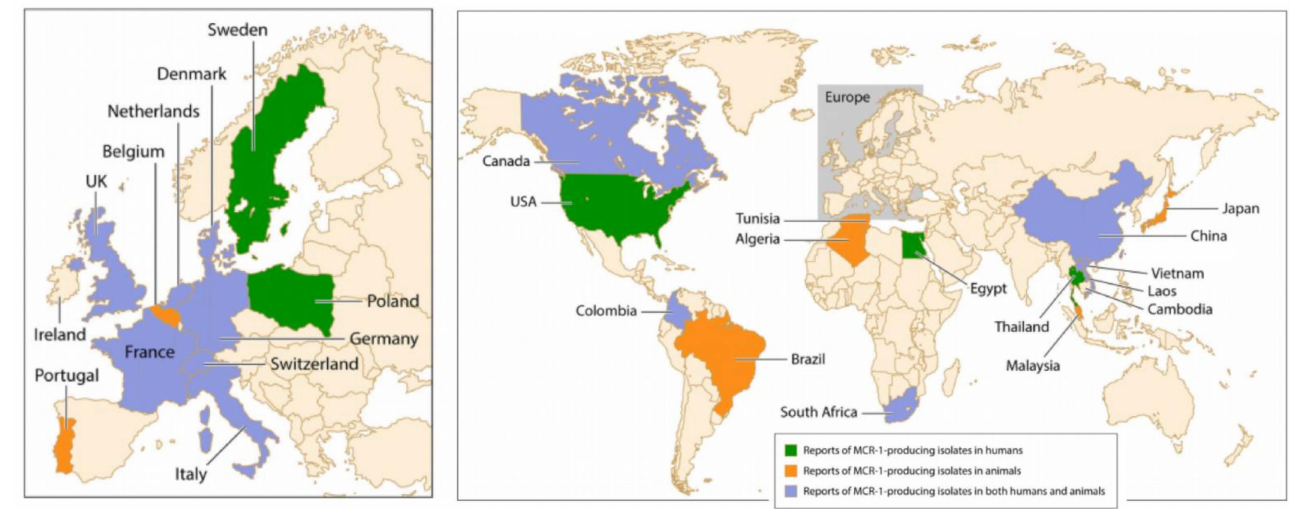
Figure 5. Worldwide distribution of mcr-1 -producing isolates in humans and animals